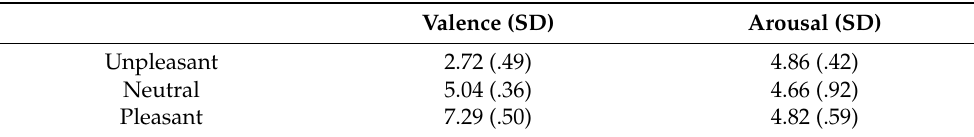
Table 1. Pre-evaluated valence and arousal ratings for the stimulus collection. Values for valence are based on the degree of reported pleasantness on a scale of 1-9, where 9 represents very pleasant and 1 represents very unpleasant. Values for arousal are based on the degree of reported arousal on a scale of 1-9, where 9 represents very arousing and 1 represents very